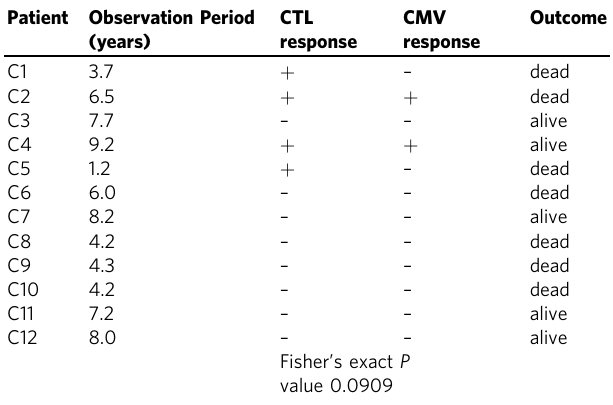
Table 3 Individual survival data of the SART3 peptide vaccine trial.